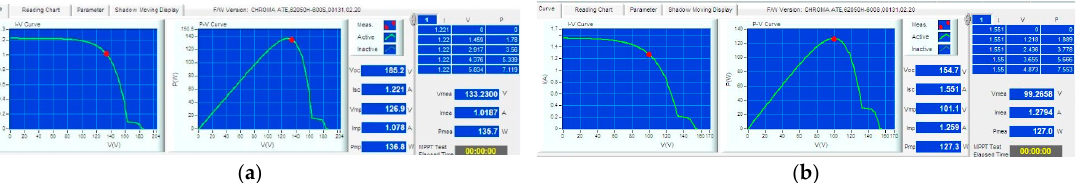
Figure 11. The tracking point of I-V and P-V curves under 1000 W/m 2 ( a ) 500 W ( b ) 750 W ( c ) 1000 W.